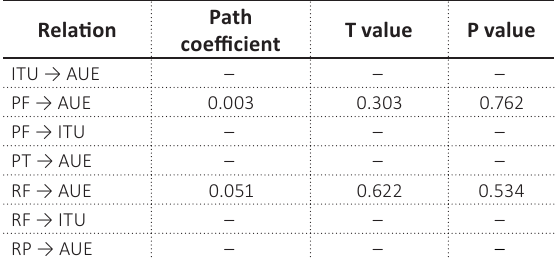
Table 6. Indirect effect